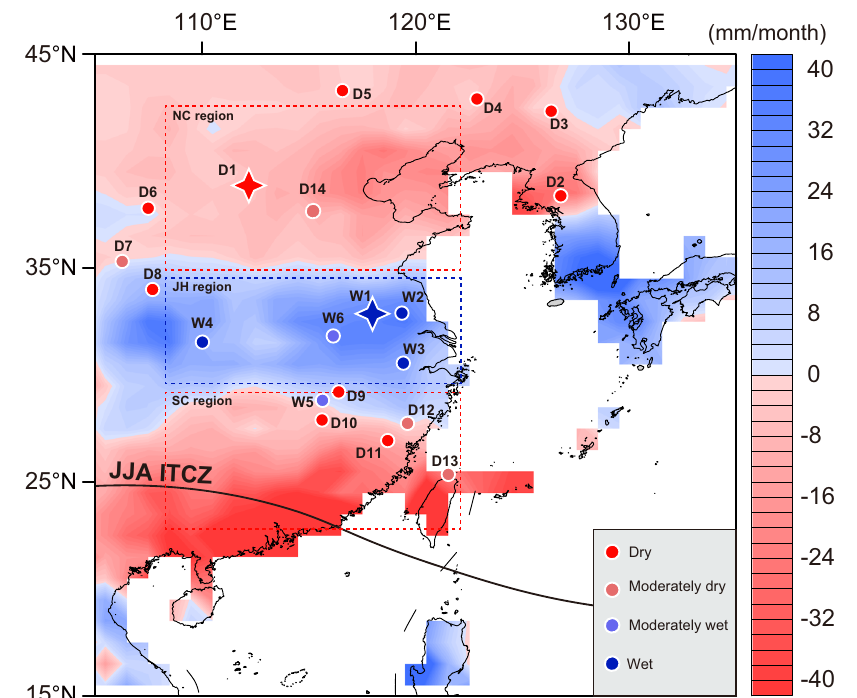
Fig. 1 Map of June-August precipitation anomalies during El Niño-like state in East Asia with the locations of last millennium precipitation reconstructions used in this study. Locations that were wetter during the LIA than during the MWP are indicated by blue symbols, while those that were drier during the LIA than during the MWP are indicated by red symbols. The stars denote the precipitation records used for reconstruction of the index of the tropical Paci fi c mean-state in this study (see Supplementary Table S1). Background shading shows the empirical orthogonal function mode 1 (EOF1) of instrumental (GPCP) summer (June-August, JJA) precipitation anomalies over East Asia during the 17 ENSO events that occurred between 1960-2020 CE (same as an El Niño-like state), which indicated an increase (decrease) of summer precipitation in the JH region (NC region) under an El Niño-like state. That areas with positive precipitation anomalies are shaded in blue, while those with negative precipitation anomalies are shaded in red. The dashed rectangular boxes indicate the tripole pattern of precipitation anomalies in East Asia that are the basis for reconstructing the mean state of the tropical Paci fi c from East Asian JJA precipitation